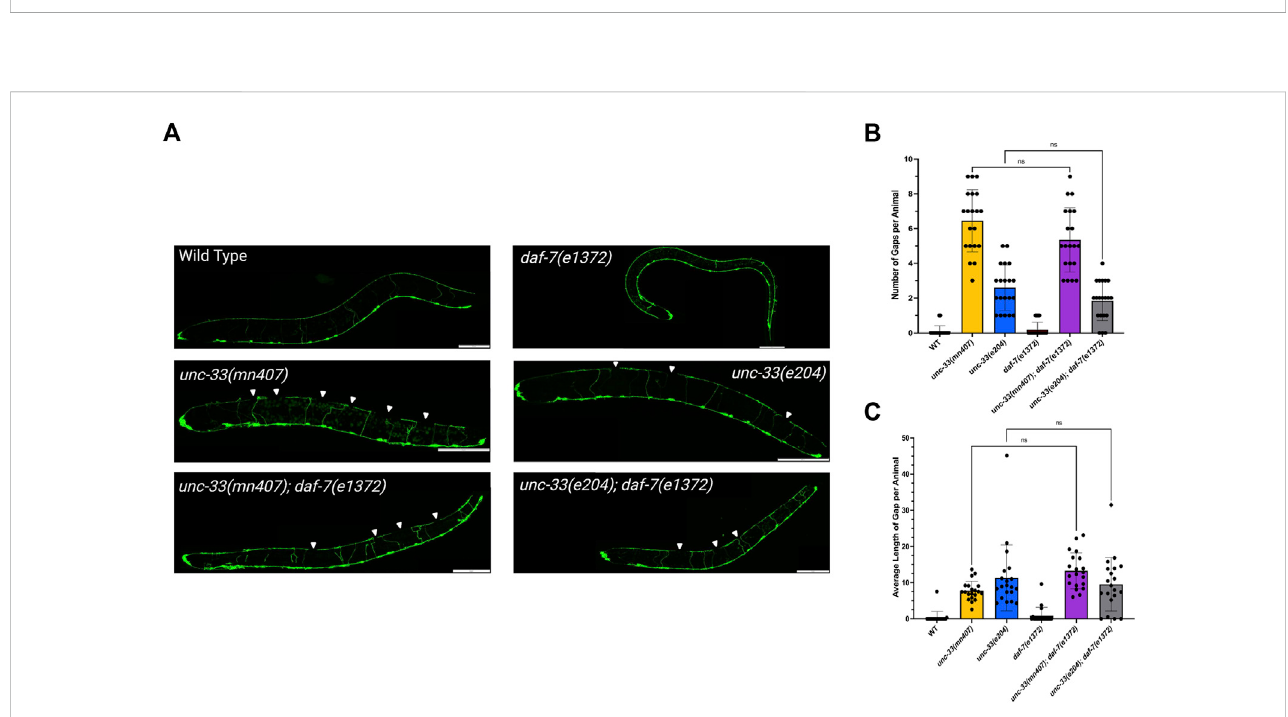
FIGURE 3 The introduction of daf-7 mutation into an unc-33 mutant background does not rescue axonal outgrowth defects seen in unc-33 mutants (A) Images taken of the dorsal (top) and ventral (bottom) nerve cords of all the strains as dauers or the L3 larval stage. White Arrows indicate a gap within the dorsal nerve cord. (B) Average gaps within thedorsal nerve cord per animal for eachstrain. (C) Average length of thegaps per animal for each strain. Statistical analysis was performed using the Kruskal – Wallis ’ s test and the Dunn ’ s multiple comparisons test. However, unc-33(mn407) and unc-33(e204) were statistically different from wildtype ( p < 0.001). n = 20 animals per strain. ns = not signi fi cant. Scale bar: 50